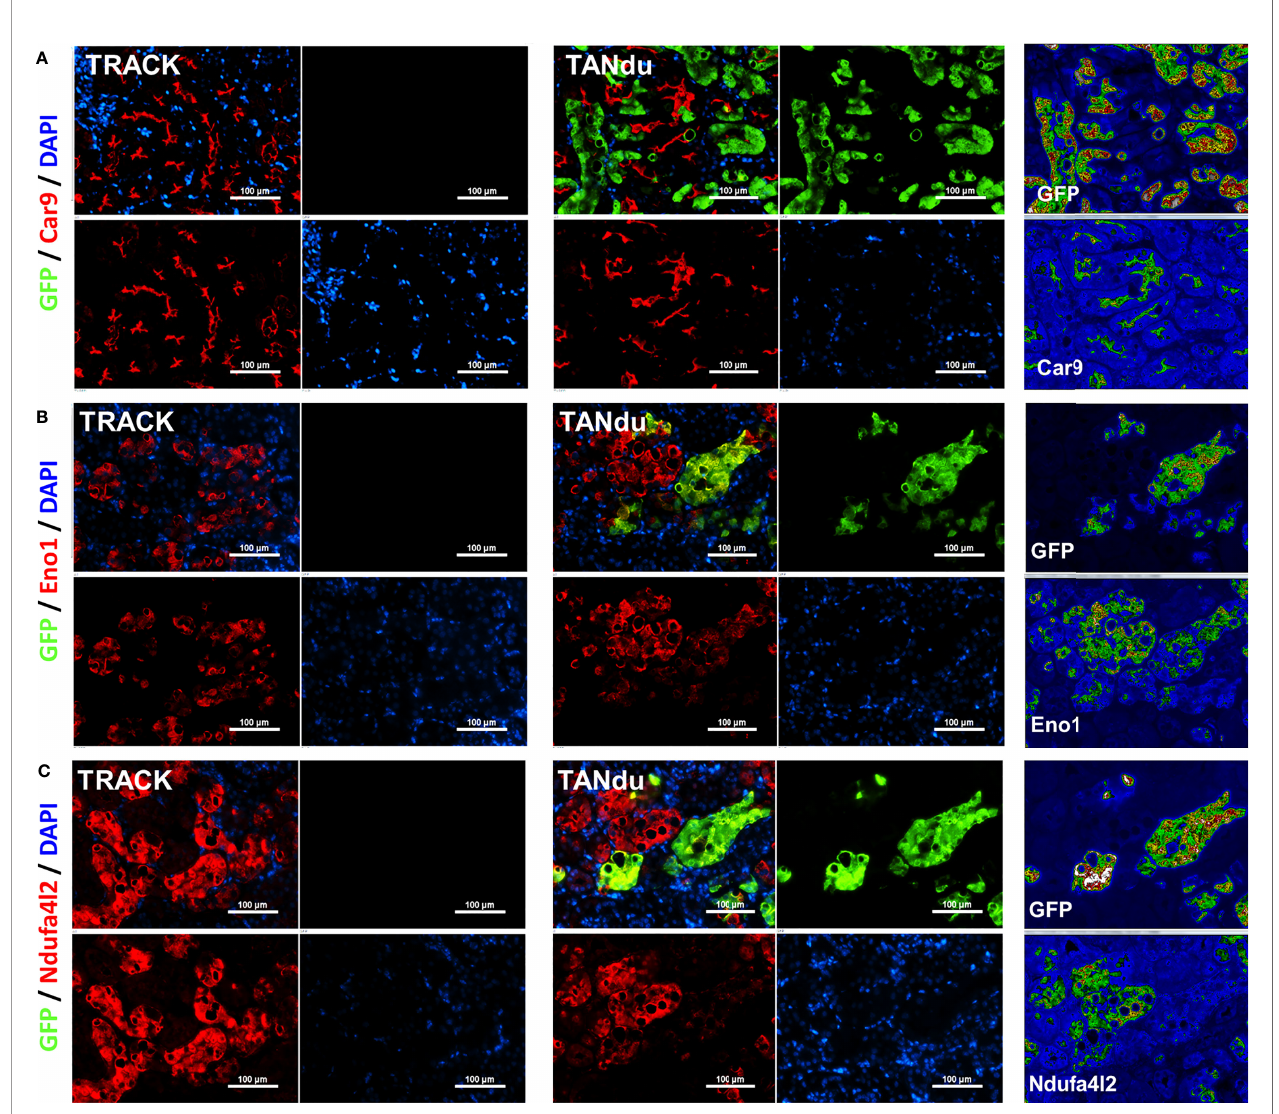
FIGURE 4 | Expression of Car9 and Eno1 is reduced in proximal tubules expressing shNdufa4l2. Immuno fl uorescence of Car9 (red, (A) , Eno1 (red, (B) , Ndufa4l2 (red, (C) , GFP (green, marking the expression of shNdufa4l2), and cell nuclei (blue). Staining of TRACK kidneys is shown to the left, and heat-maps of staining intensities in the TANdu kidneys is shown to the right. Panels show representative immunostainings of kidney cortices from three independent mice of each genotype. Magni fi cation; x200, scale bar; 100 m m. Representative images are shown. The antibodies used are listed in Table S4